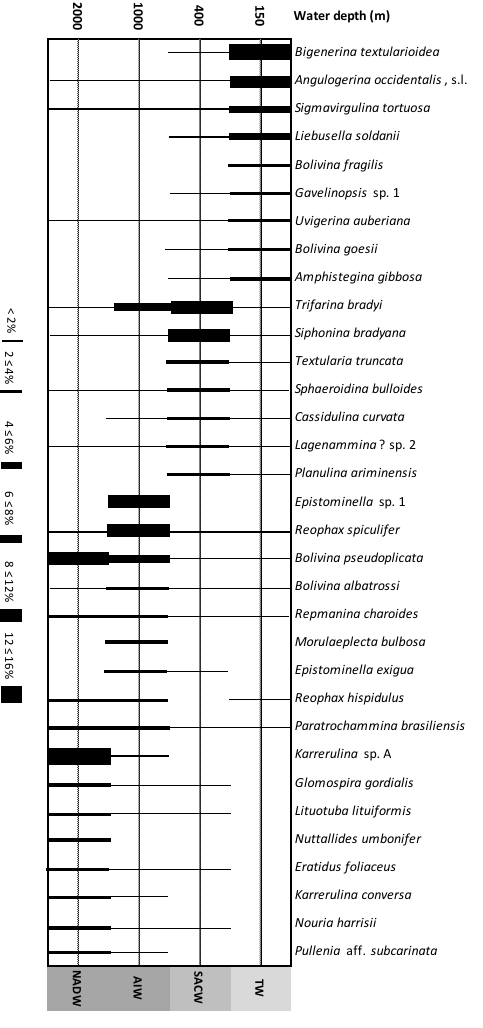
Figure 10. Species and their respective relative frequencies at the integrated layer.